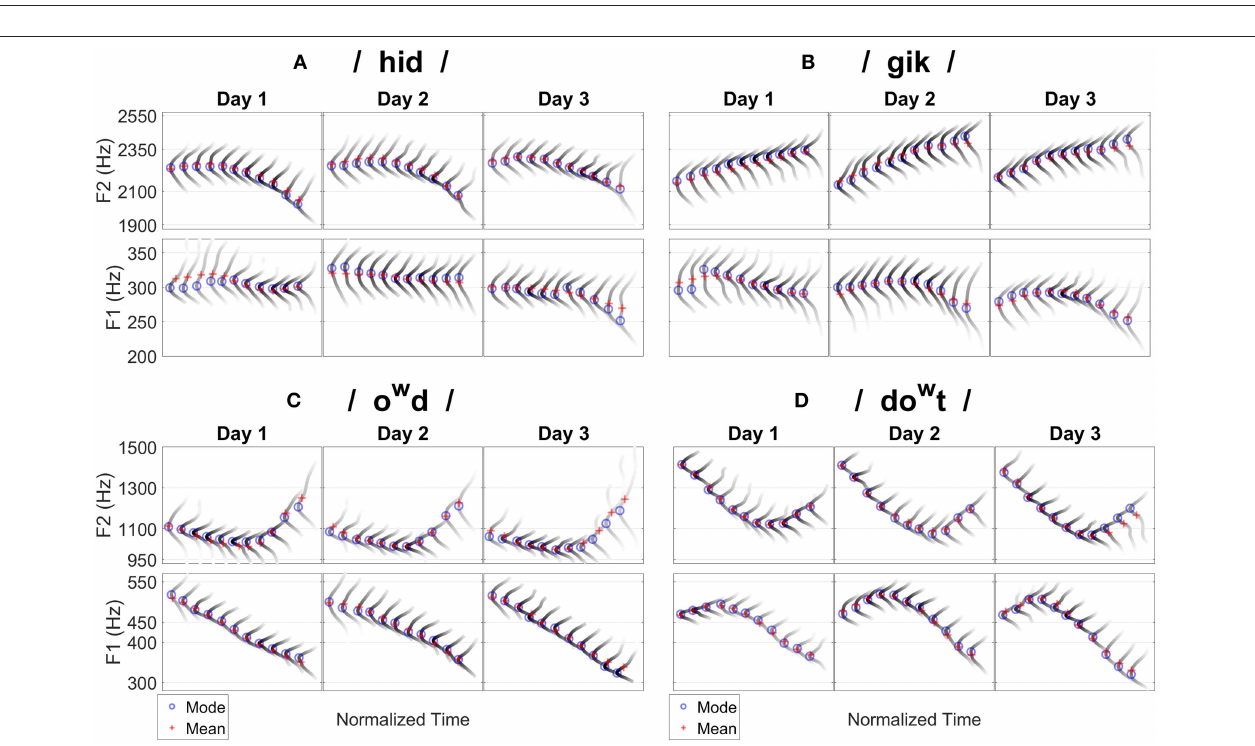
FIGURE 3 | Skew values for each time point, separately by day (1 = blue, 2 = red, 3 = green). Solid circles indicate significant skewness (significance level set at 0.05).